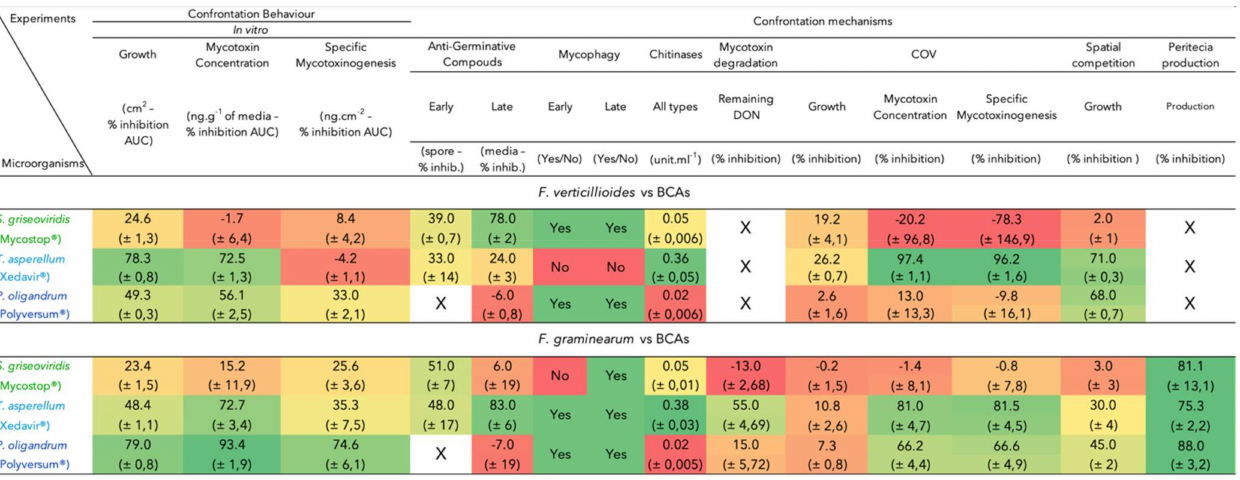
Figure A1. Overview table of BCAs behaviors and mechanisms of action during confrontation with F. graminearum and F. verticillioides . The columns indicate the experiments performed. The first columns (2, 3 and 4) present the results obtained in a previous work [21], the following columns (5–15) present the results obtained during this study, except for the results concerning the nutritional competition which are not quantitative. The lines indicate the microorganisms involved, lines 6–9: F. verticillioides vs. the different BCAs; lines 10–13: F. graminearum vs. the different BCAs. In each cell, the percentage of inhibition of the considered pathogenic factor is presented, or if necessary, the raw quantity considered ( ± standard deviation). The colors represent the level of inhibition in comparison to other BCAs (from the best performing, in green, to the worst performing, in red). Myco: Mycostop ® , Xeda: Xedavir ® , Poly: Polyversum ®